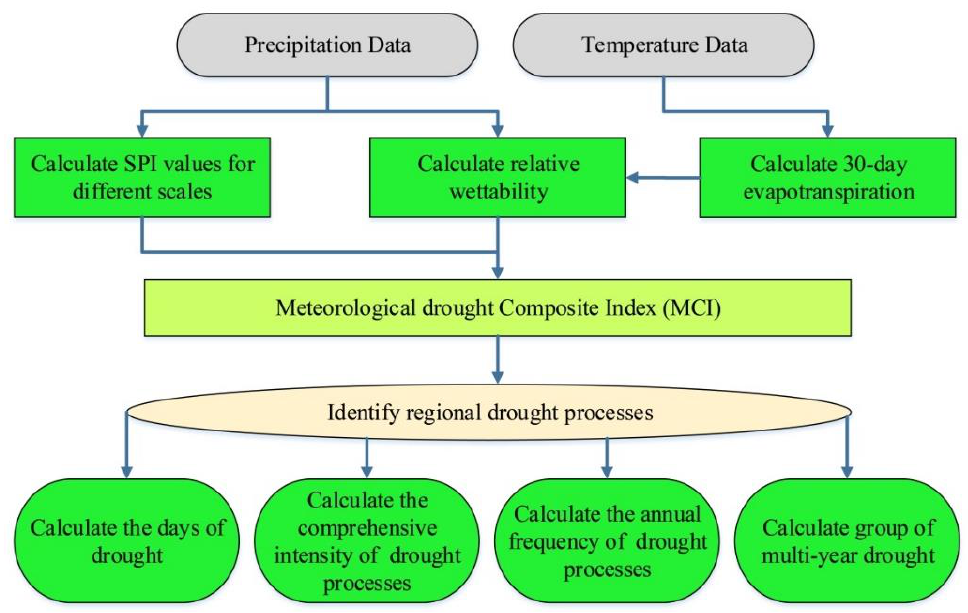
Figure 2. Flow chart for calculating the drought index and the intensity of the drought process.